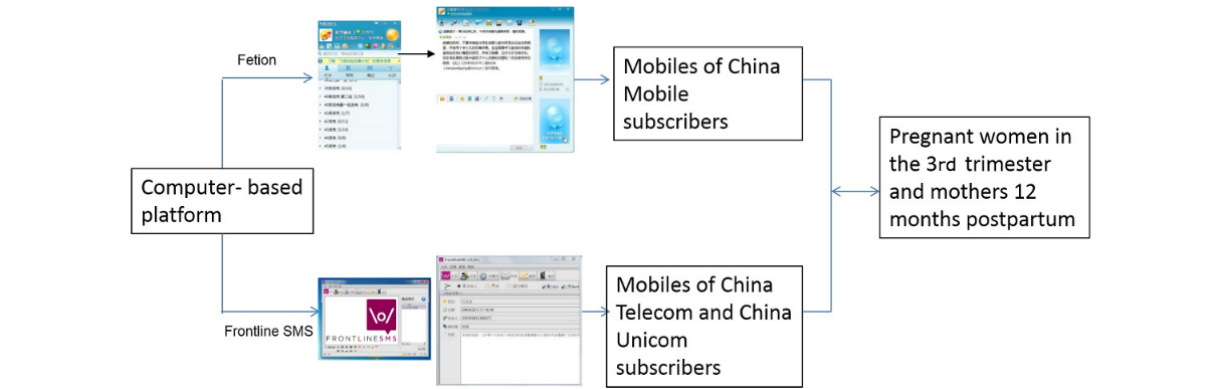
Figure 1. The short message service (SMS) text messaging operation